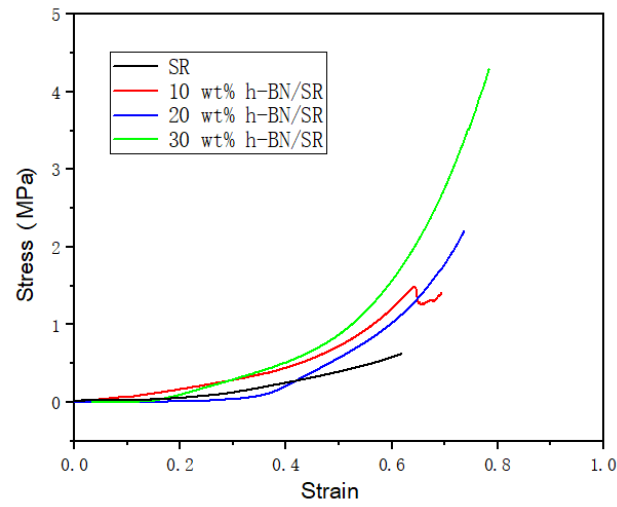
Figure 8. Compressive strength of SR composite filled with different mass percent of h-BN parti- cles.